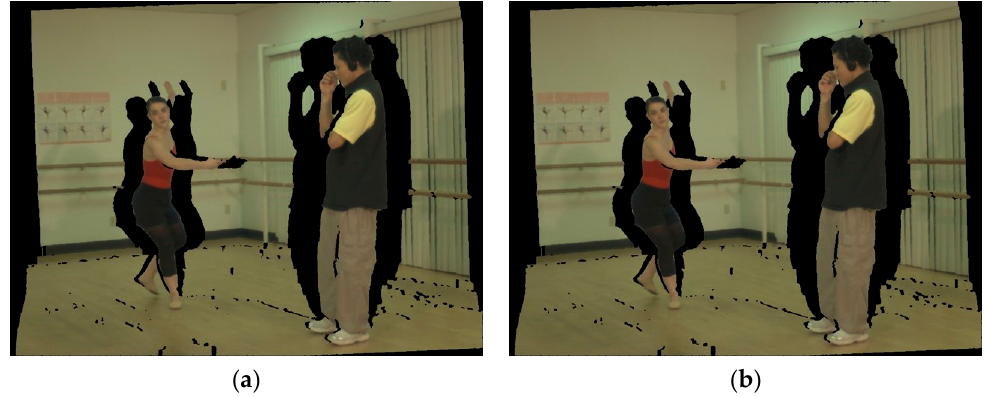
Figure 10. Virtual views with the same holes warped from the main and auxiliary views. ( a ) V (cid:48) ( b ) V (cid:48) aux